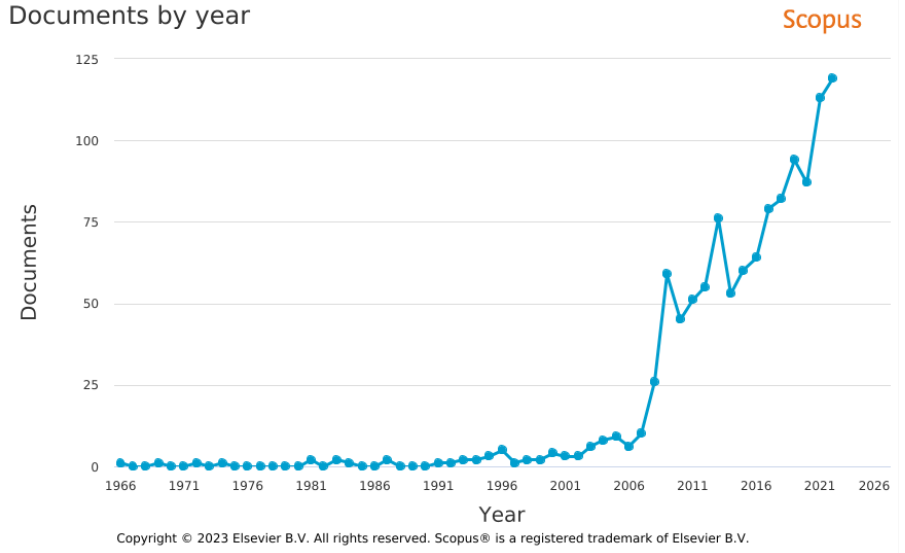
Figure 6. Documents results of Q1 in Scopus. Source: Authors ’ elaboration.